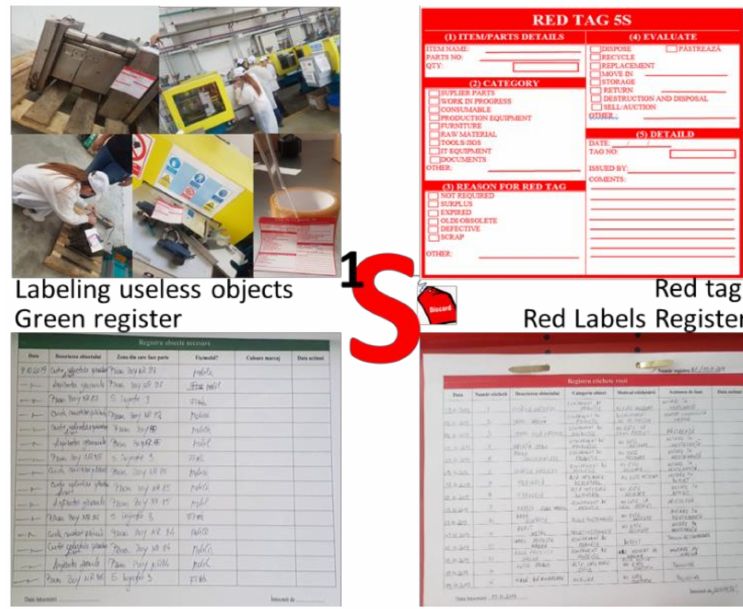
Figure 22. The use of first stage of 5S